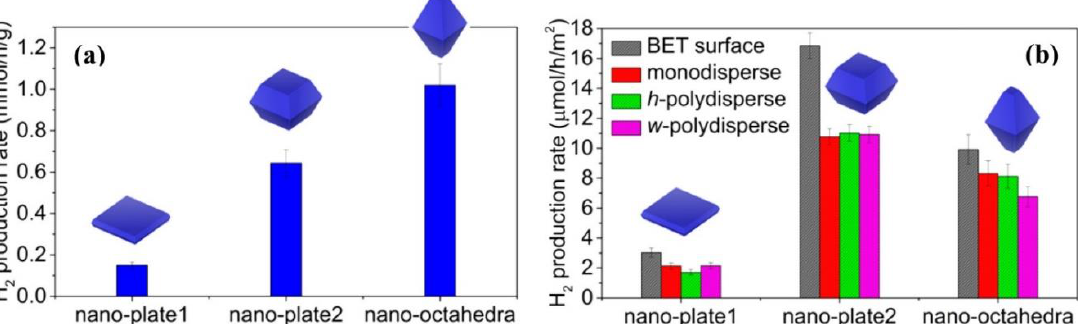
Figure 9. ( a ) Mass and ( b ) surface normalized photocatalytic hydrogen evolution rate of three anatase TiO 2 nanocrystals with different {001} to {101} facet ratios. Reprinted with permission from [95]. Copyright © 2017 American Chemical Society.